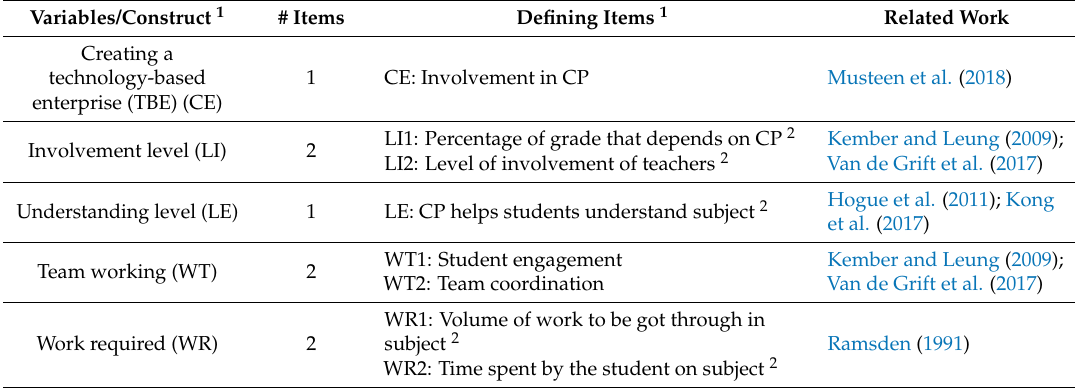
Table 3. Overview of the dependent and independent